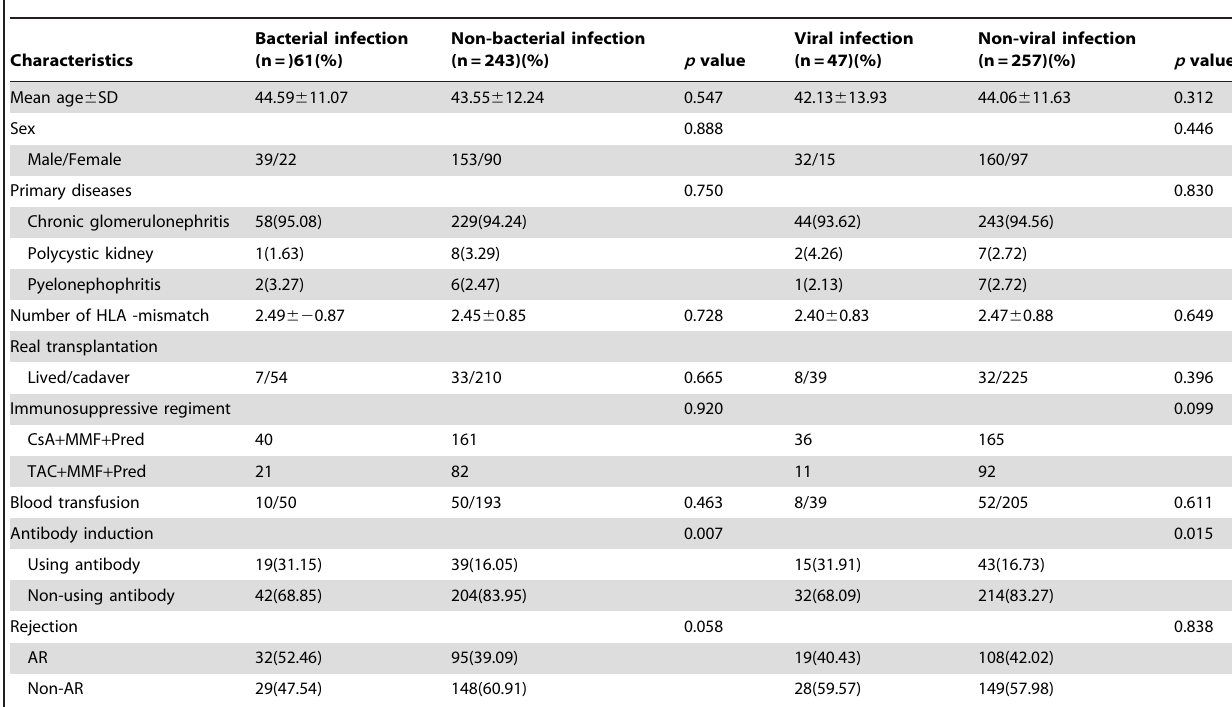
Table 1. No significant differences in age, sex, primary disease, human leukocyte antigen mismatches, blood transfusion, renal transplantation or immunosuppressant regimen were found between patients with infection and those without (controls) (Table 1). The incidence of acute rejection (AR) following renal transplantation was similar in both groups. However, the groups that suffered from bacterial infection and from viral infection were Table 1. Comparison of clinical characteristics between patients with infection and non-infection.